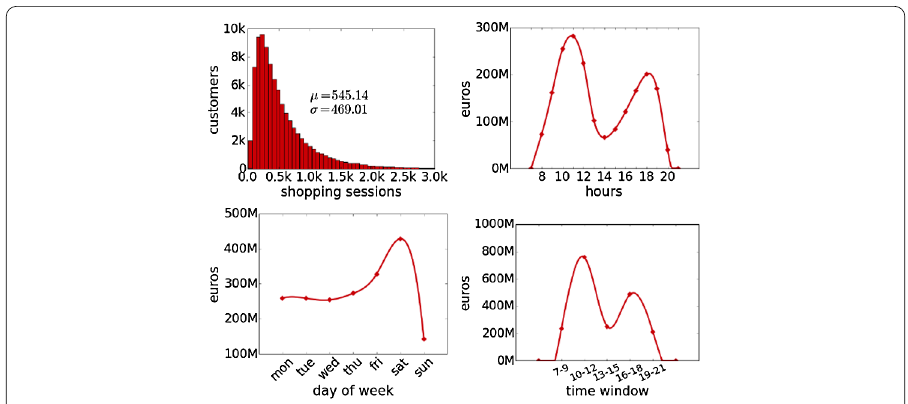
Figure 4 Dataset statistics. Distributions of number of shopping sessions per customer (upper left), amount spent per hours (upper right), amount spent per day of week (lower left), and amount spent per time window (lower